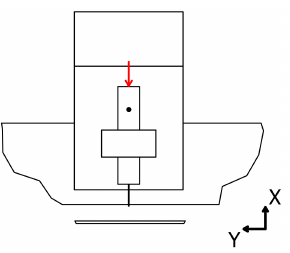
Figure 10. Excitation and measurement point on cutting head.